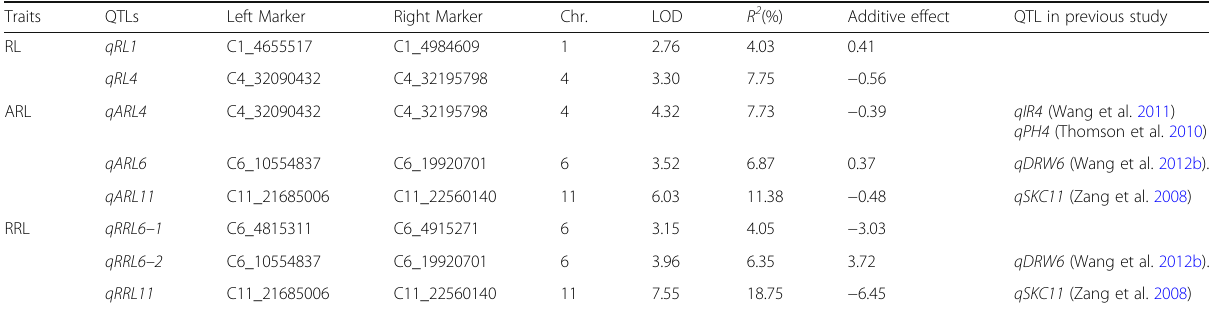
Table 1 QTLs for RL, ARL and RRL based on the mean trait values of three replications in 184 RILs Traits QTLs Left Marker Right Marker Chr. LOD R 2 (%)